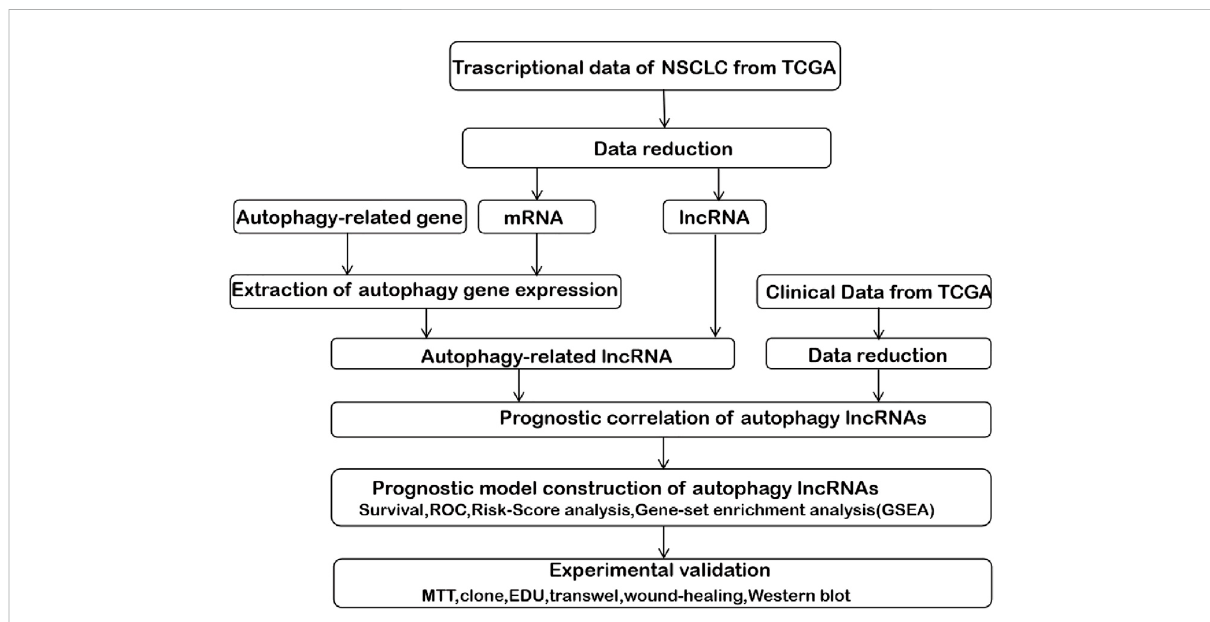
FIGURE 1 The comprehensive prognostic analysis framework of autophagy-associated lncRNAs in NSCLC based on the TCGA database.